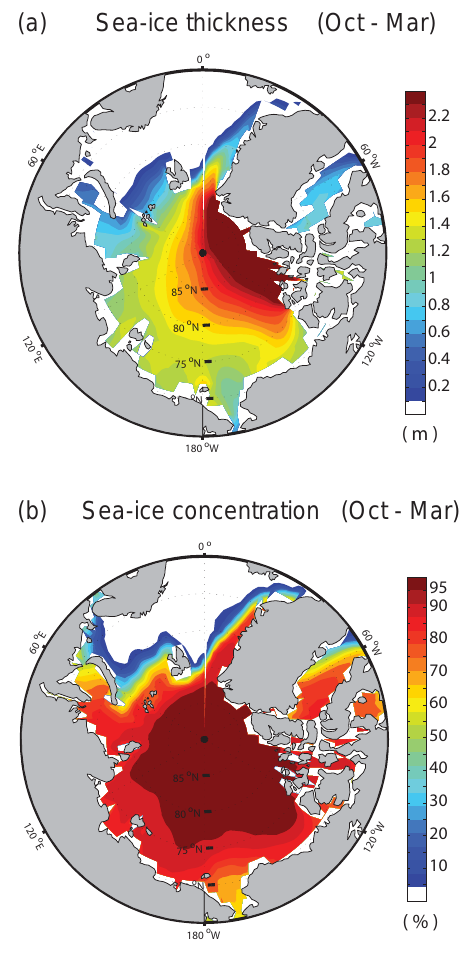
Figure 1. (a) Sea ice thickness (a) and (b) sea ice concentration (%), averaged from October 2009 to March 2010. Sea ice thickness is from PIOMAS and sea ice concentration data are from